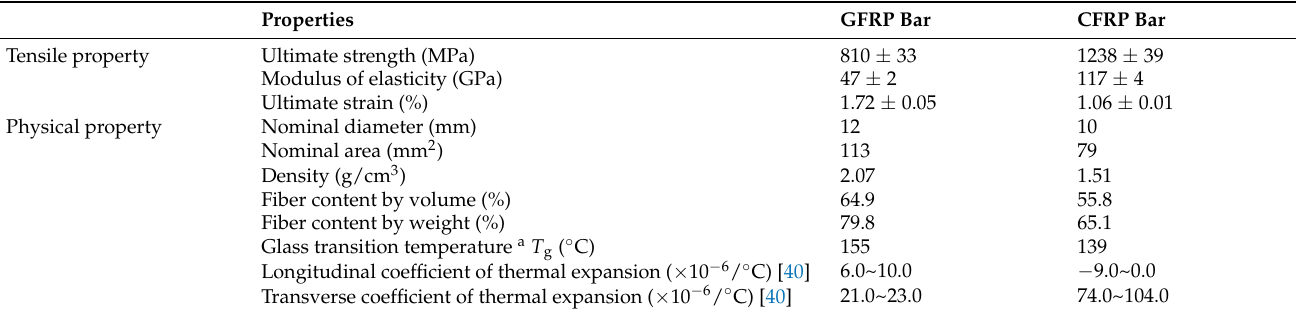
Table 2. Tensile and physical properties of G/CFRP bars used in this research.